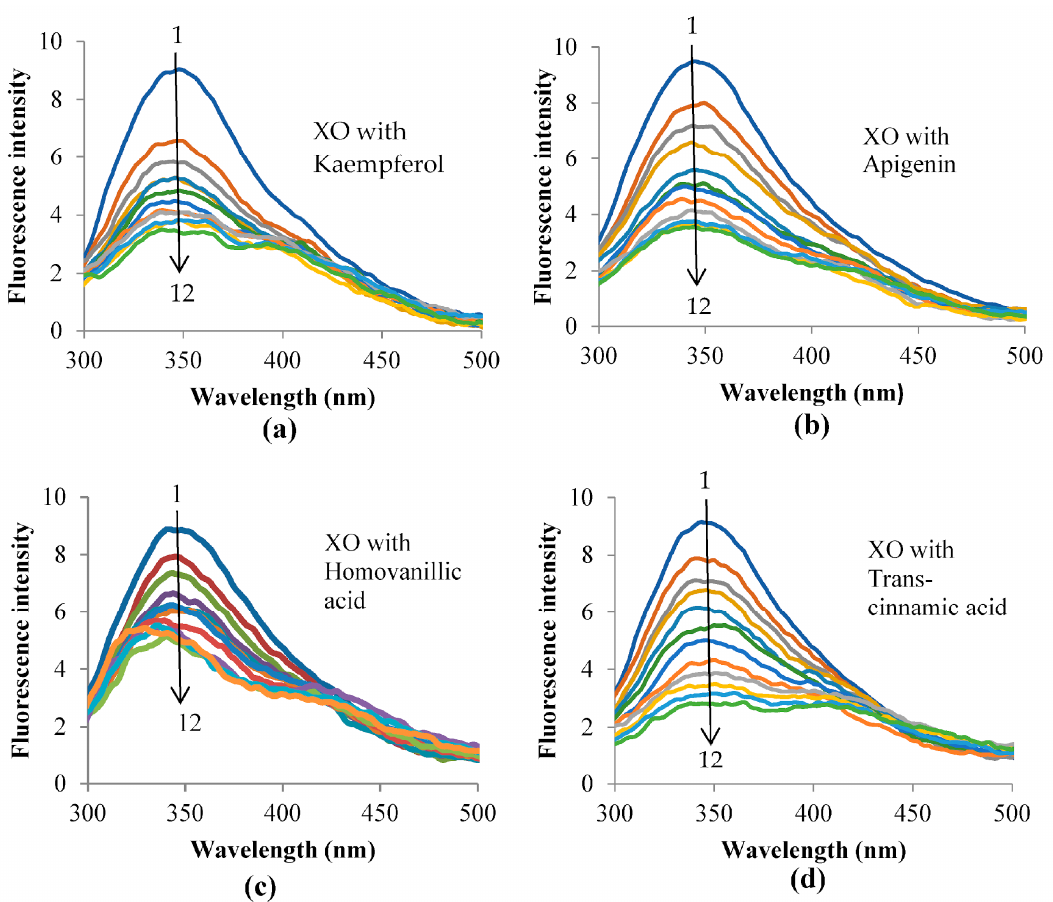
Figure 4. Fluorescence spectra of XO in the absence and presence of ( a ) kaempferol, ( b ) apigenin, ( c ) homovanillic acid, and ( d ) trans -cinnamic acid at different concentrations with pH 7.5, T = 298 K, λ ex = 280 nm. The concentration of XO = 4.0 × 10 −7 mol L −1 , and the concentrations of the respective inhibitors = 0, 1.24, 2.48, 3.69, 4.90, 6.10, 7.28, 8.45, 9.62, 10.77, 11.90, and 13.03 × 10 −6 mol L −1 for curves 1 (blue) → 12 (green), respectively.